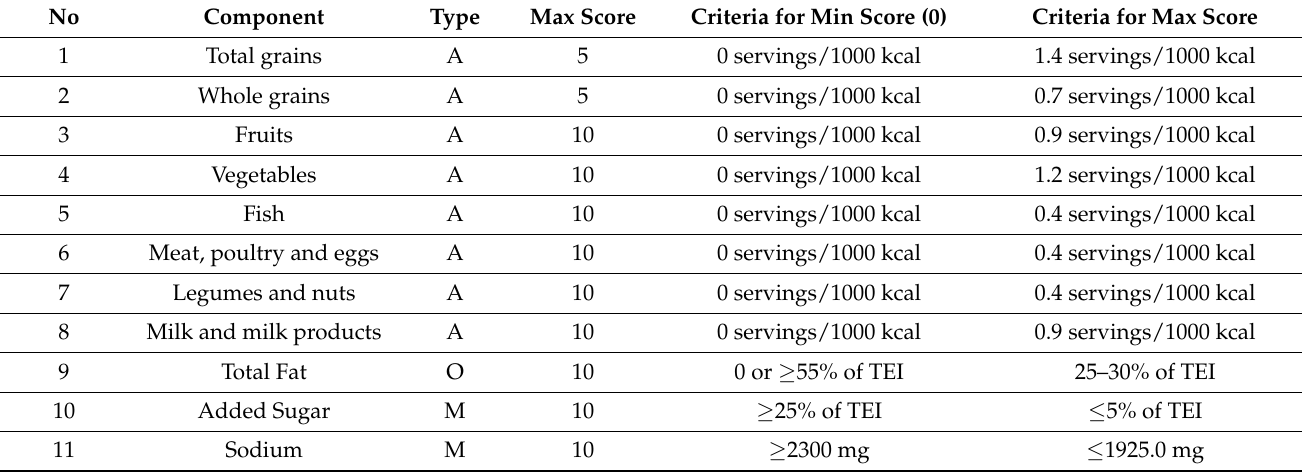
Table 6. The new standardized Malaysian Healthy Eating Index